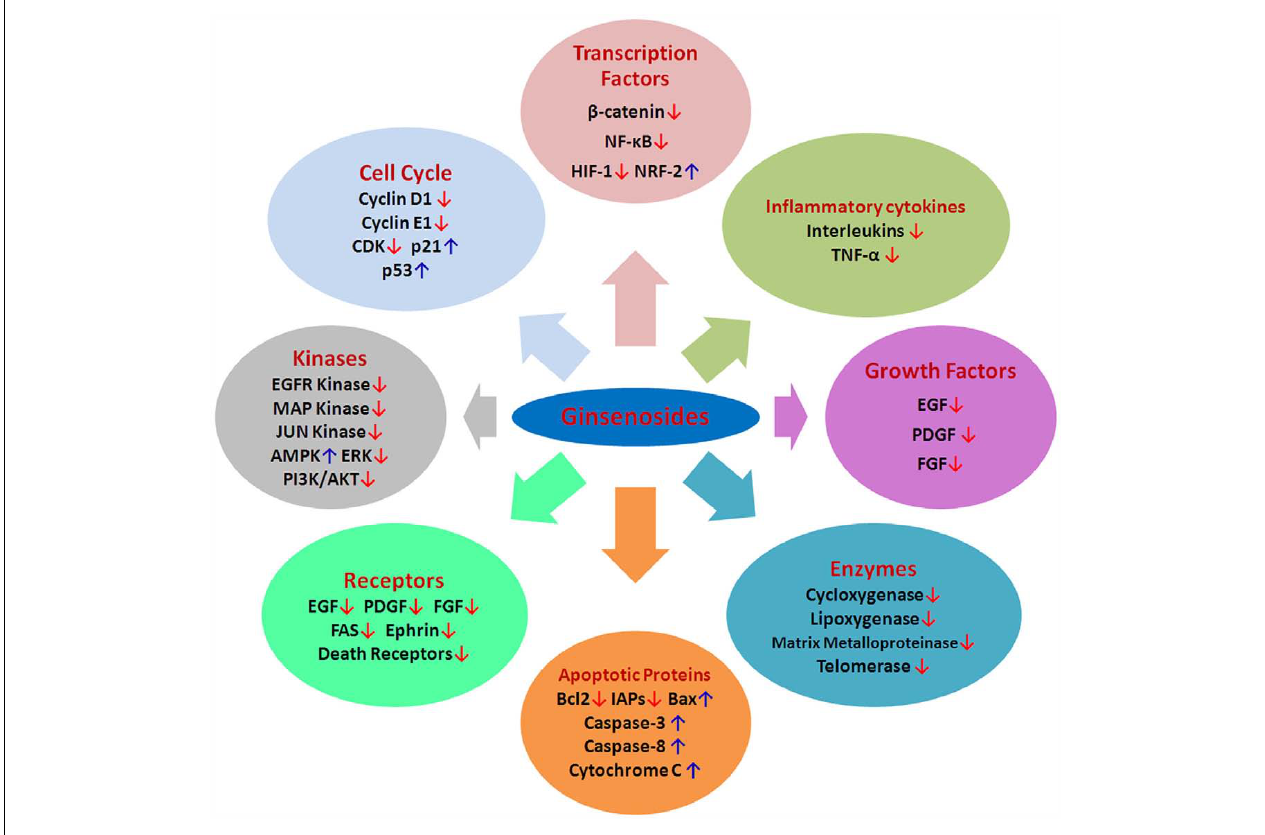
FIGURE 3 | Possible cellular and molecular mechanisms of ginsenosides aginst cancer. CDKs, cyclin-dependent kinases; MDM2, murine double minute-2;VEGF, vascular endothelial growth factor; bFGF, basic fibroblast growth factor; PDGF, platelet derived growth factor, MMP, matrix metalloproteinase; IAP, inhibitory apoptotic protein;TNF,